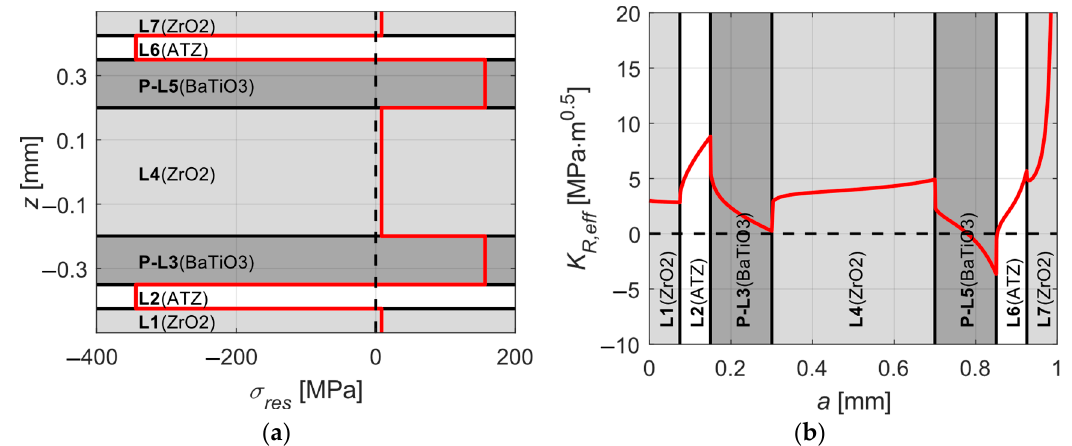
Figure 3. Scheme of the first optimization phase.